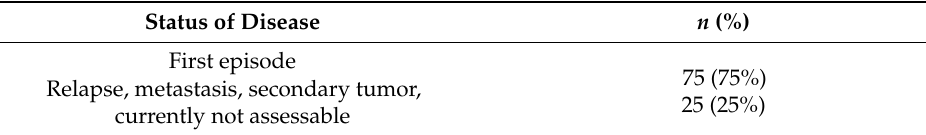
Table 3. Participants’ disease